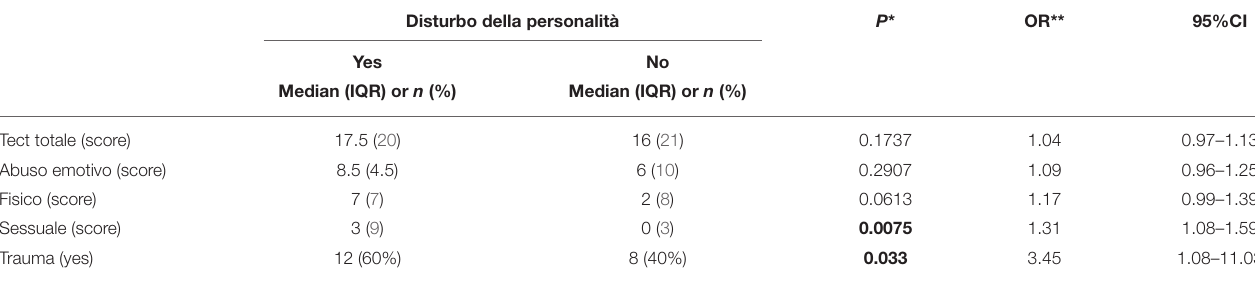
TABLE 2 | Factors related to personality disorder (univariate analysis).